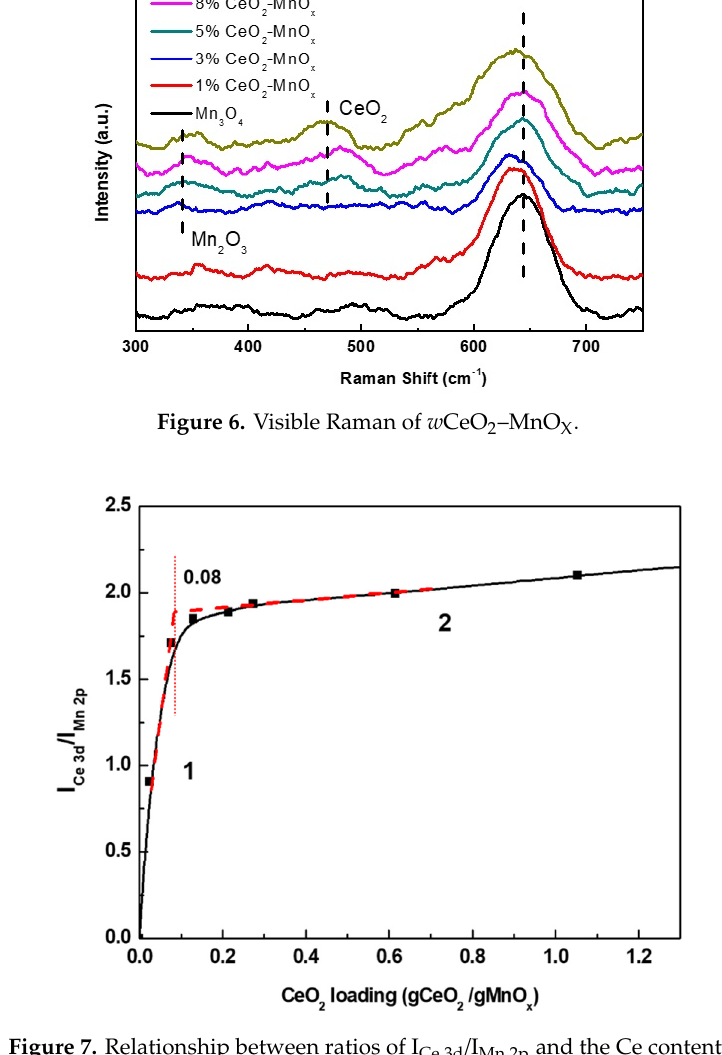
Figure 7. Relationship between ratios of I Ce 3d / I Mn 2p and the Ce content.